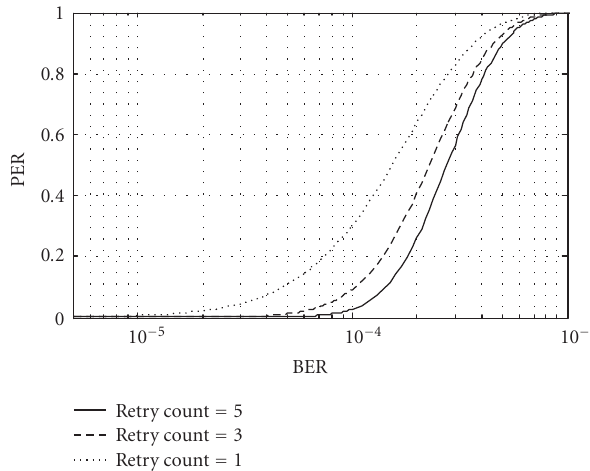
Figure 15: PER against BER for di ff ering ARQ retry